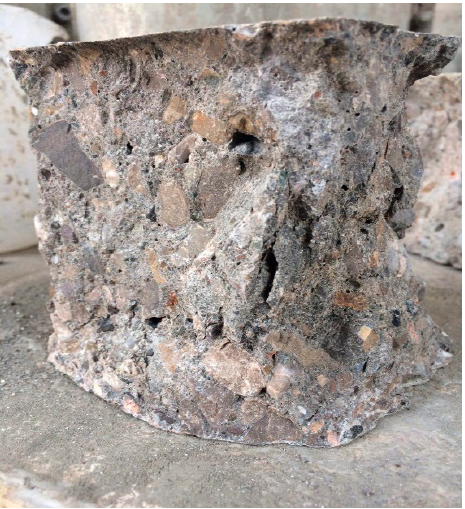
Figure 1. Compressive strengths of the mixtures at different ages.